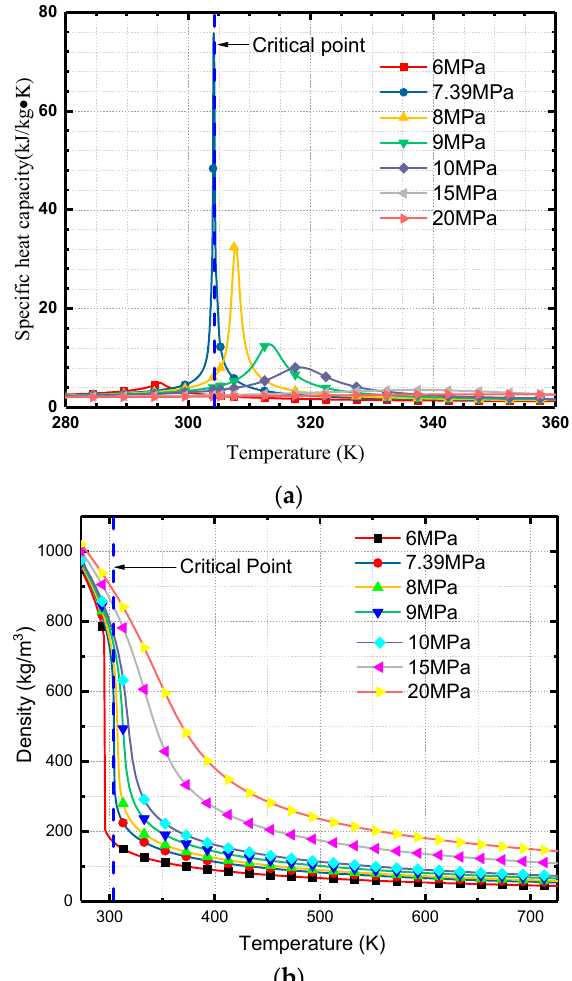
Figure 6. CO 2 density and specific heat capacity dependence on temperature and pressure. ( a ) Specific heat capacity, ( b ) density.